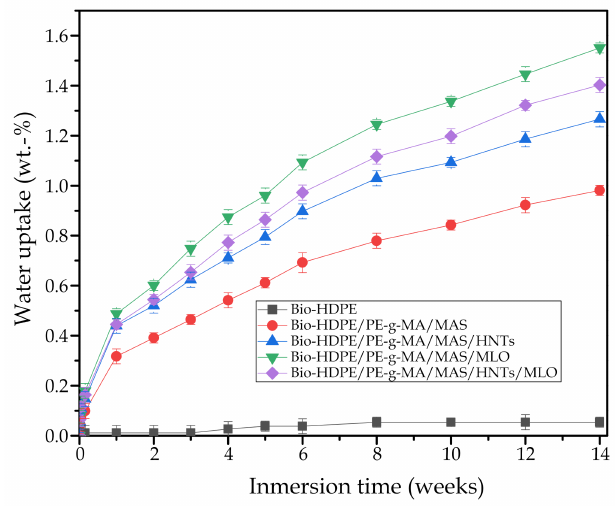
Figure 10. Water uptake of the injection-molded pieces of neat Bio-HDPE and its green composites with argan shell micronized (MAS) compatibilized with PE-g-MA, MLO, and with HNTs as additional